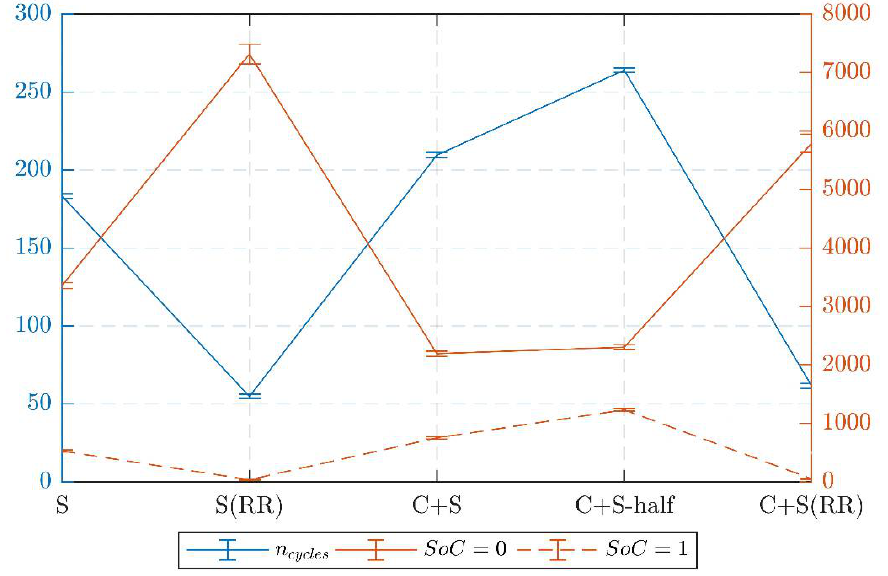
Figure 9. Usage of the ESS: charge/discharge cycles per year ( n cycles ), axis on the left, and hours/year at a given SoC, on the right.